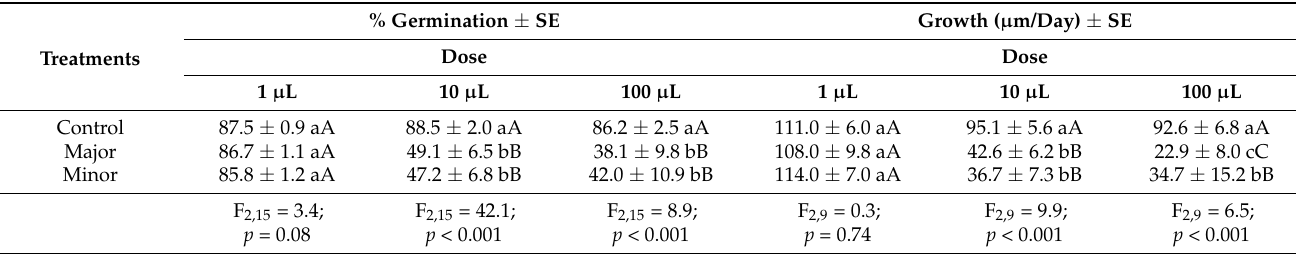
Table 1. Effects of different doses of M. sjostedti aggregation pheromone components on M. anisopliae conidial viability and germ tube growth.